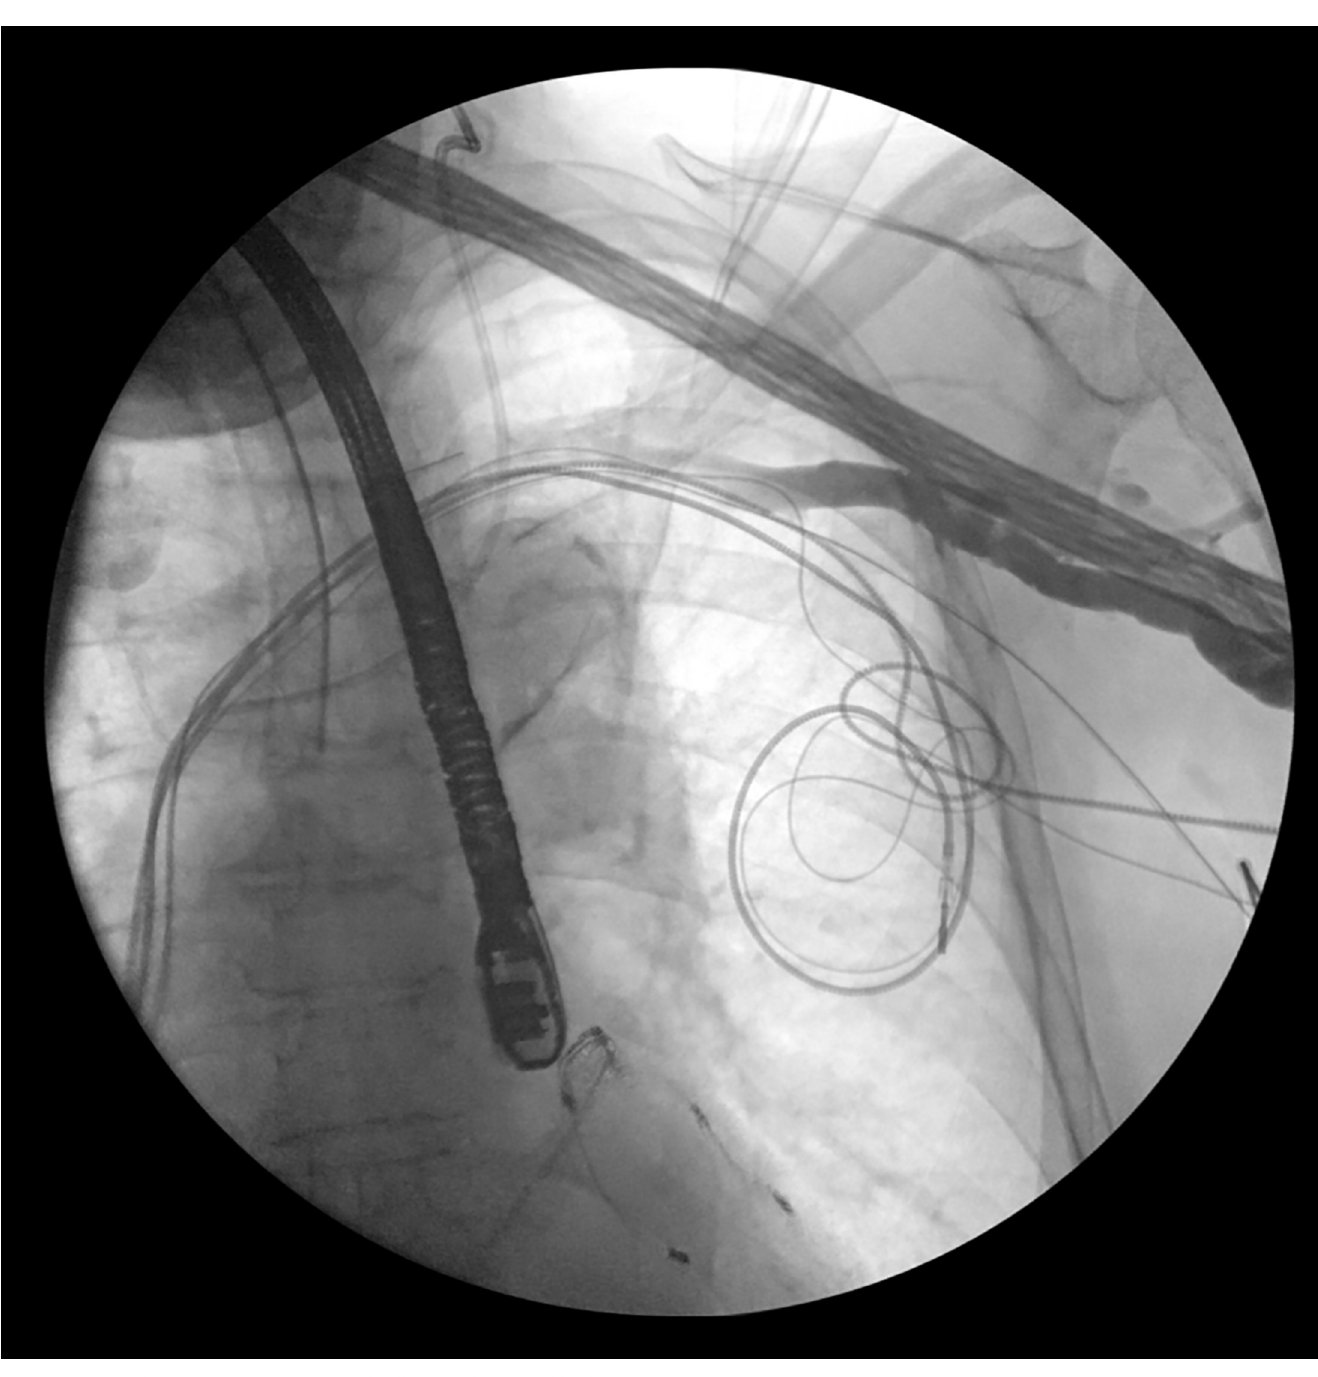
Fig 1. Angiographic venous stenosis with indwelling nonfunctional